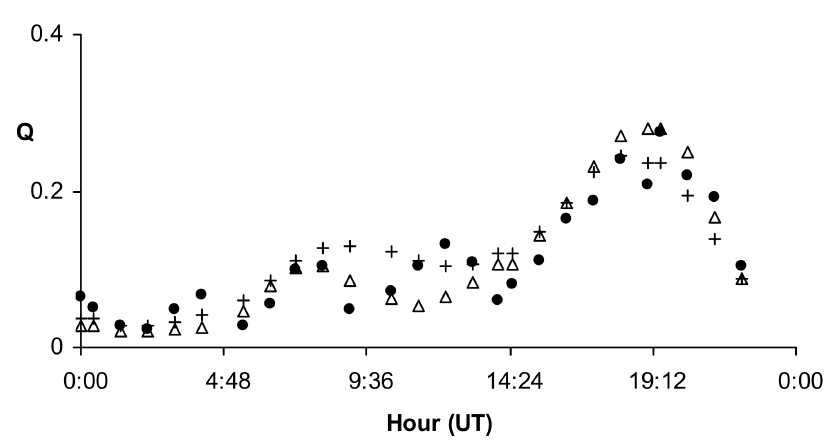
Figure 12. Allocation 43 at a threshold of 20 dB µ V/m.